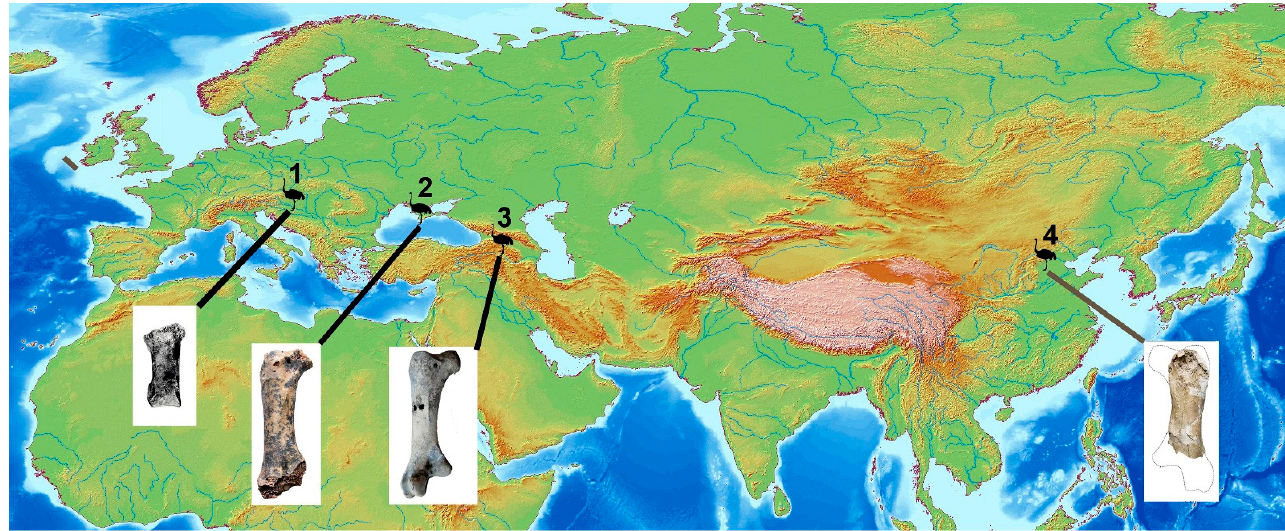
Figure 5. Map showing the distribution of skeletal remains referrable to Pachystruthio in the Lower Pleistocene of Eurasia. 1: Kisláng, Hungary (phalanx, after [24]); 2: Taurida Cave, Crimea (femur, after [23]); 3: Dmanisi, Georgia (femur, after [22]); 4: Nihewan, China (femur, this paper). The bones are not to scale.